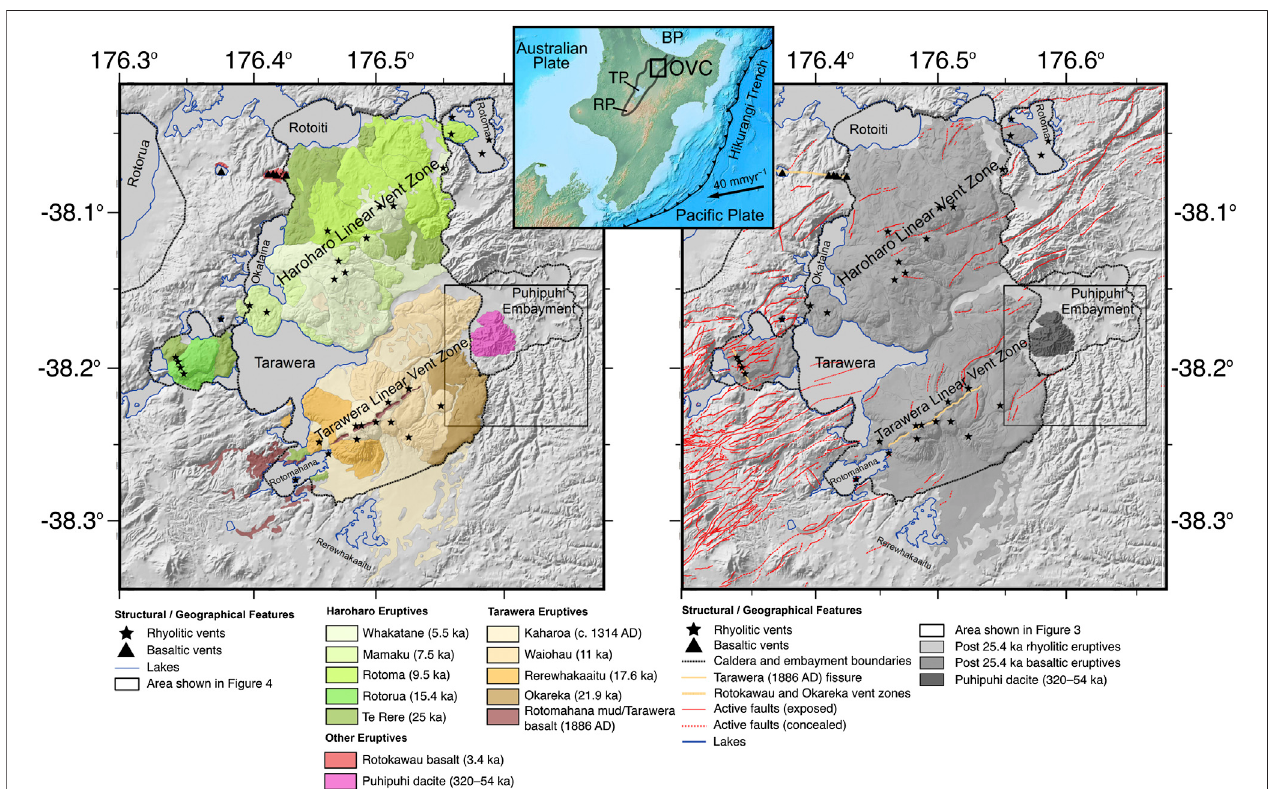
FIGURE1|Left: Young( ≤ 25 ka)eruptiveunitsoftheOkatainaVolcanicCenter. Right: StructuralfeaturesoftheOkatainaVolcanicCenter,includingthelocationof the 1886 AD Tarawera eruptive fi ssure. Inset shows the location of the TVZ (black outline) and the OVC (black box) in the North Island, New Zealand. BP: Bay of Plenty, TP: Taup (cid:1) o, RP: